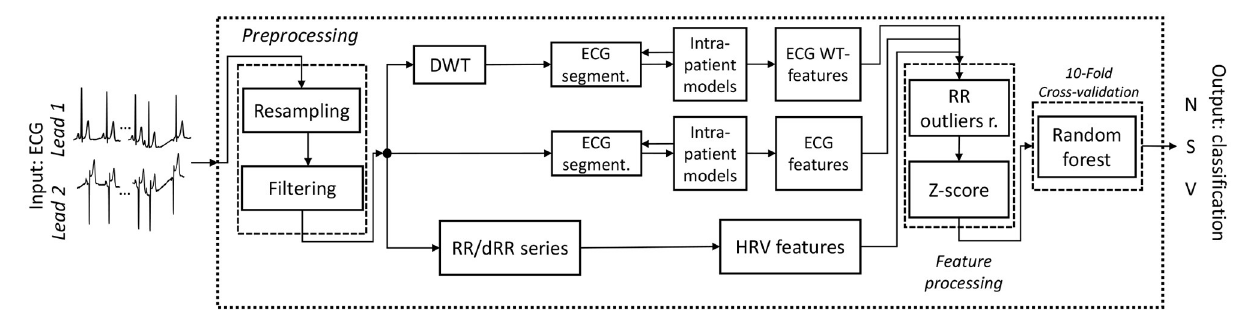
be extracted for each of the mentioned segments, any variability produced by a premature atrial or ventricular beat, should be detected even if the ECG region is not accurately delineated. Prior